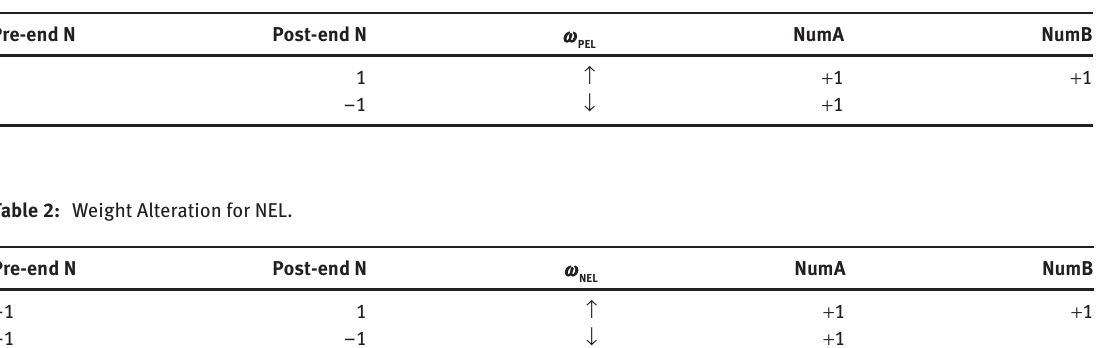
Table 1: Weight Alteration for PEL.